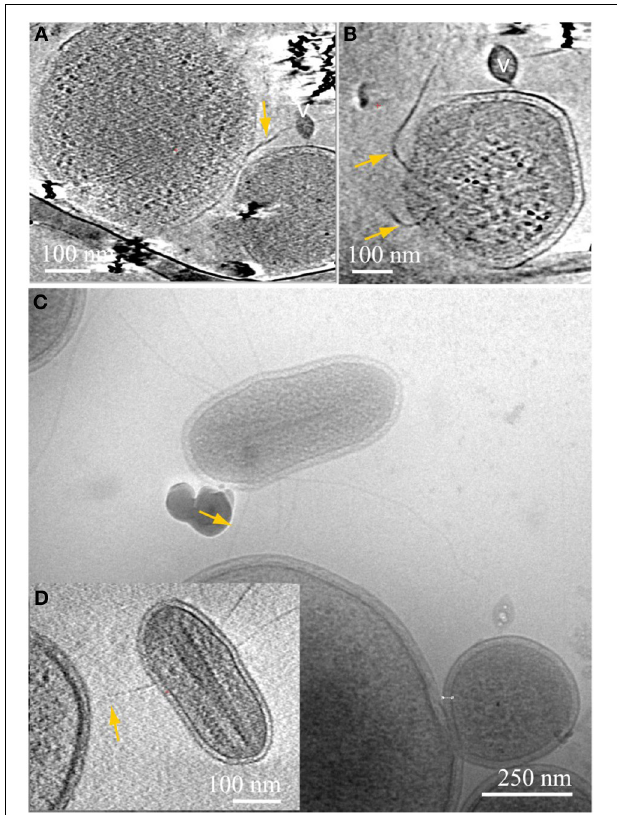
FIGURE 6 | Inter-species associations through pili. Computational slices through 3D cryo-ET reconstructions of an archaea (A) , connected to the center of an ARMAN cell, bottom right, through thick pili; the ARMAN cell sliced through a different angle is magnified in (B) . The complete trajectory can be followed in 3D but falls out of plane in these sections. (C) 2D cryo-TEM projection and inset (D) slice through 3D cryo-ET reconstruction of an unknown archaeal cell with large putative polysomes, as in inset (B) of Figure 4 . The microorganism is connected through putative pili indicated by yellow arrows to a large cell. See also Movies 5 , 6 .